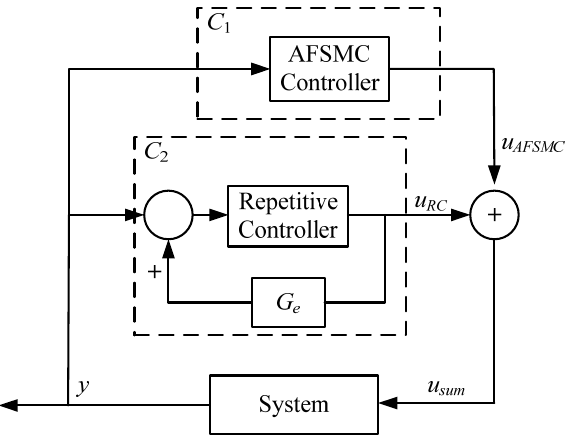
Figure 4. Block diagram of the proposed hybrid AFSMC/RC system.